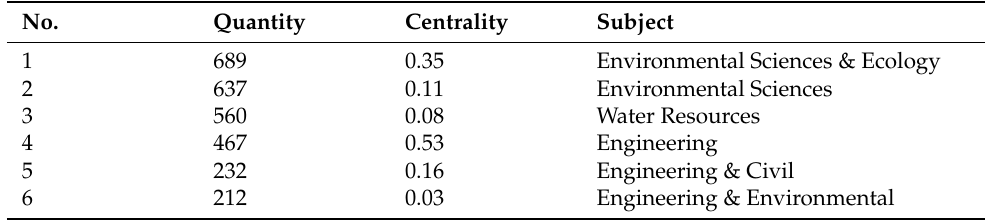
Table 1. The subject categories of the LID research based on the WOS database.